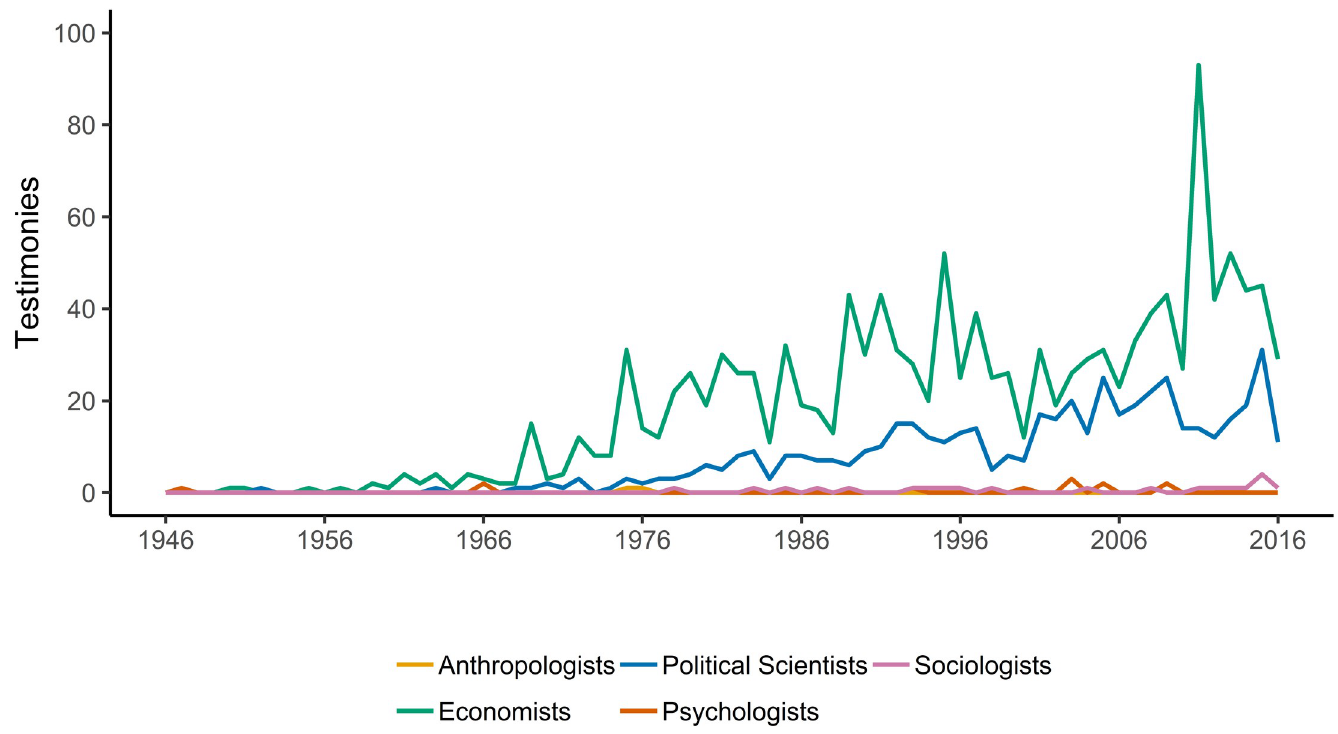
Fig 5. Think tank representation by